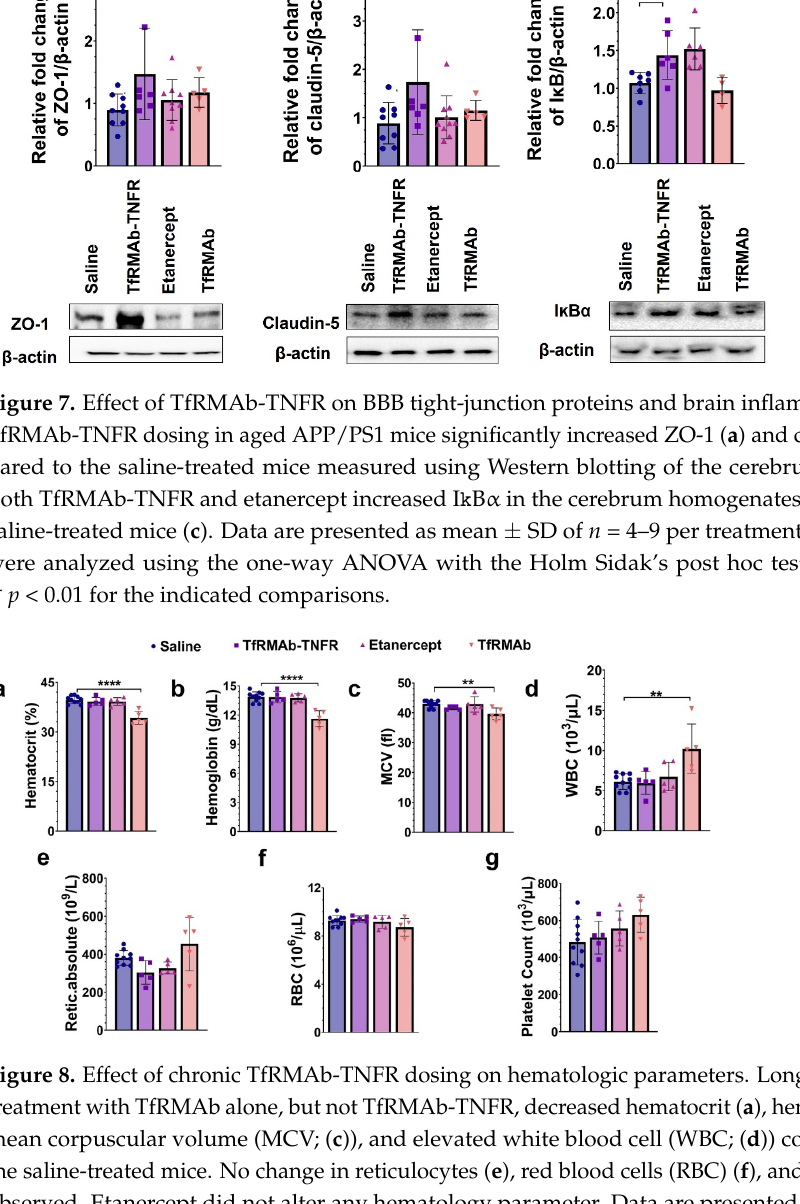
Figure 8. Effect of chronic TfRMAb-TNFR dosing on hematologic parameters. Long-term (ten-week) treatment with TfRMAb alone, but not TfRMAb-TNFR, decreased hematocrit ( a ), hemoglobin ( b ), and mean corpuscular volume (MCV; ( c )), and elevated white blood cell (WBC; ( d )) count compared to the saline-treated mice. No change in reticulocytes ( e ), red blood cells (RBC) ( f ), and platelets ( g ) was observed. Etanercept did not alter any hematology parameter. Data are presented as mean ± SD of n = 5–10 per treatment group, and data were analyzed using the one-way ANOVA with the Holm Sidak’s post hoc test. ** p < 0.01 and **** p < 0.0001 for the indicated